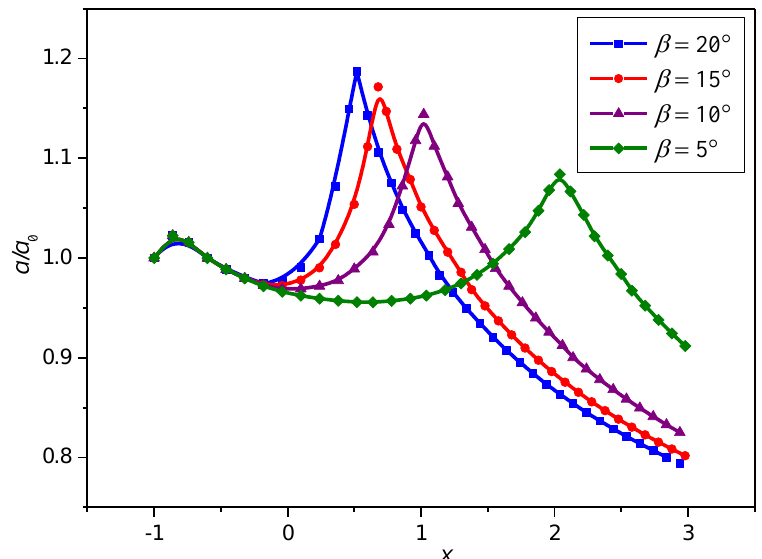
Figure 9. Variation in dimensionless amplitude for different initial amplitudes and slope height h s = 0.18.